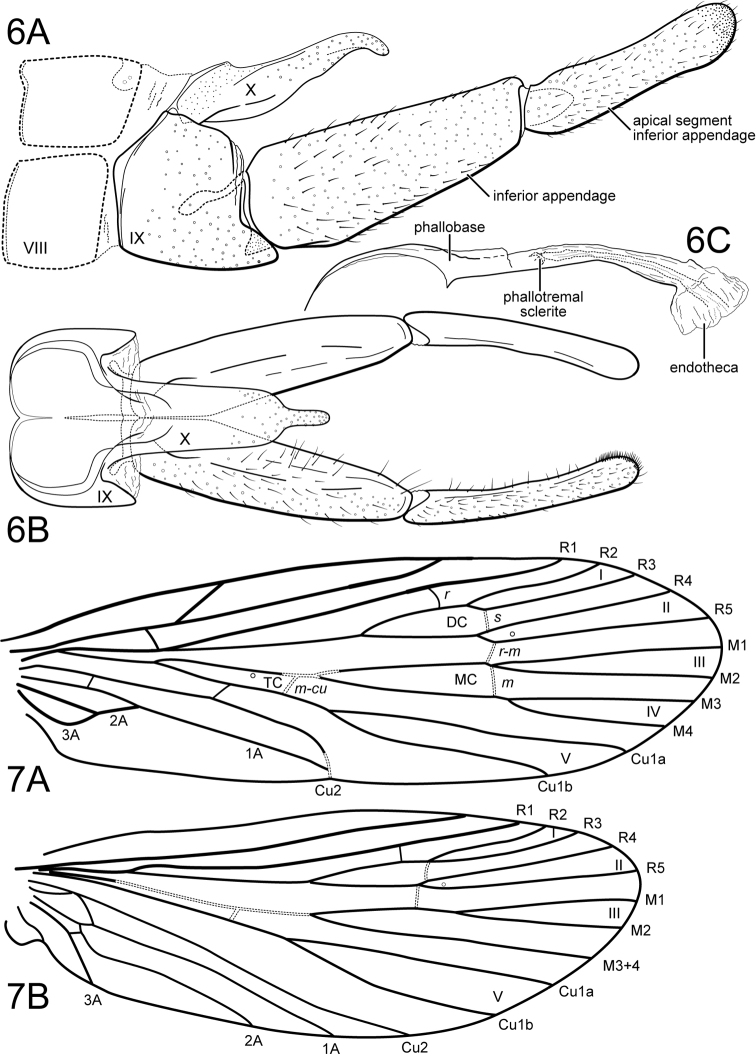
6Hydrobiosellaandina sp. n. Male genitalia A segments VIII-X, lateral B segments IX-X, dorsal C phallus, lateral 7Hydrobiosellaandina, sp. n. Male wings A forewing B hind wing